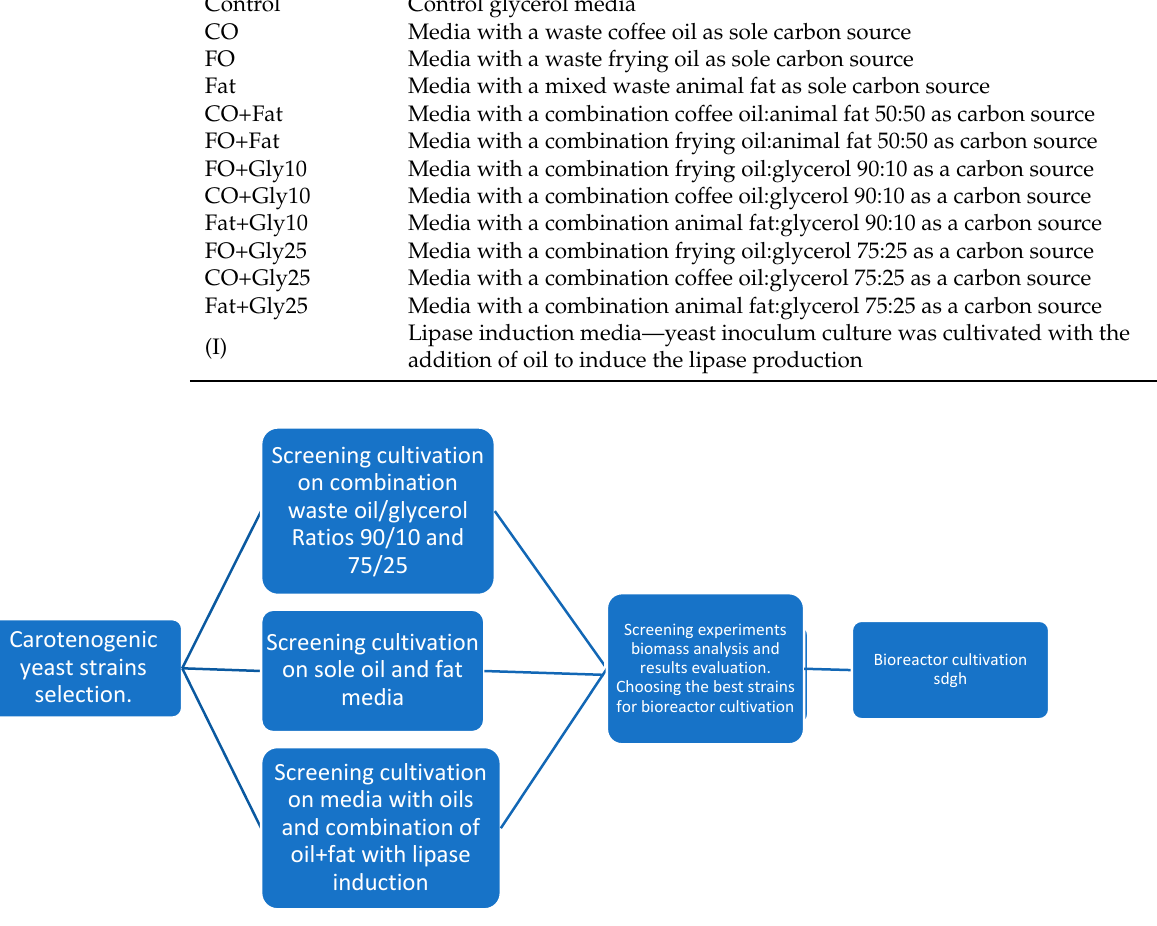
Table 1. List of abbreviations and explanations.